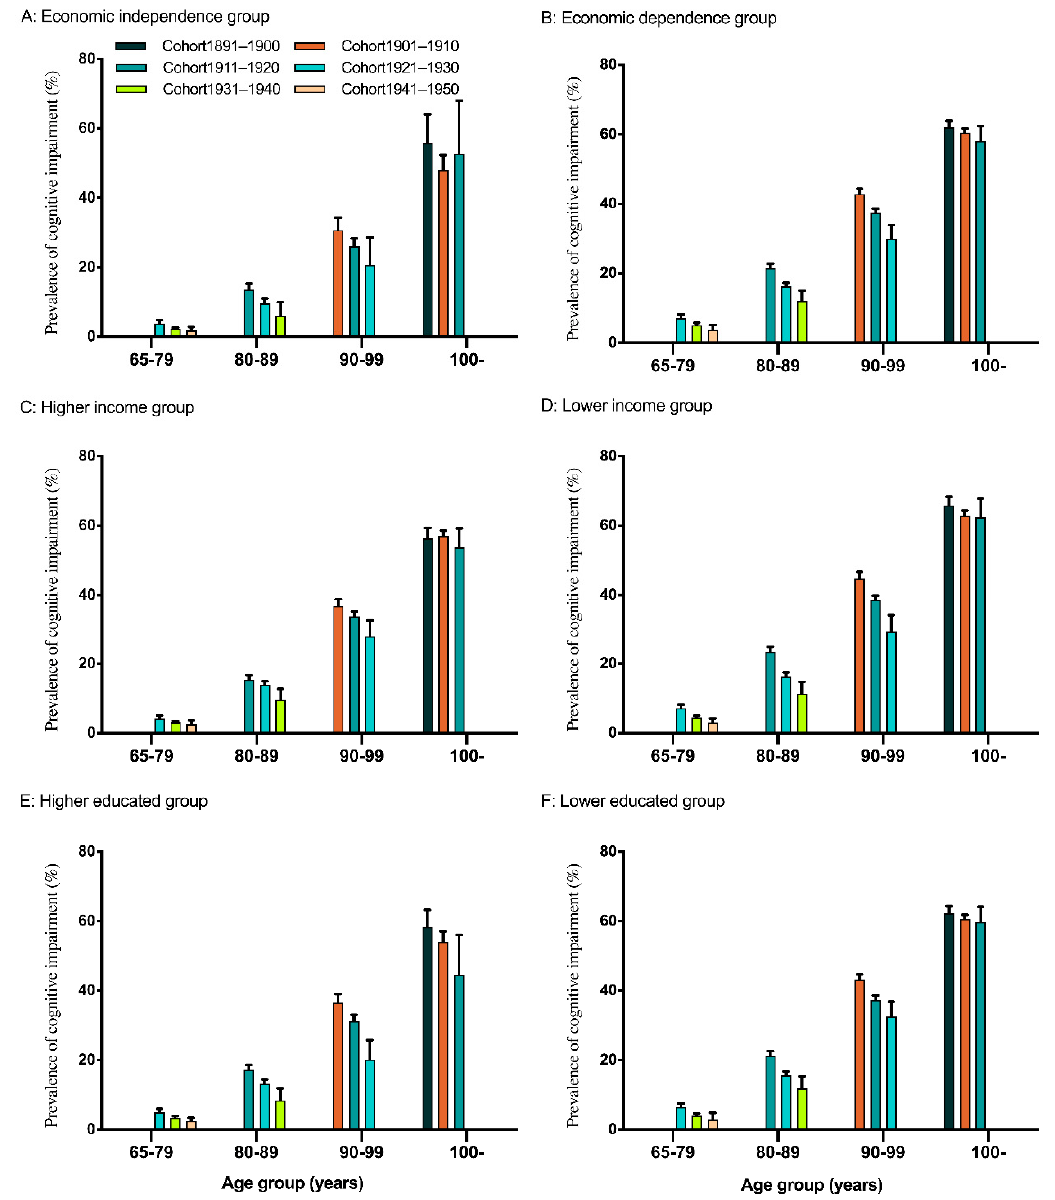
Figure 1. The prevalence of cognitive impairment (%) by different socio-economic status group older among older adults.